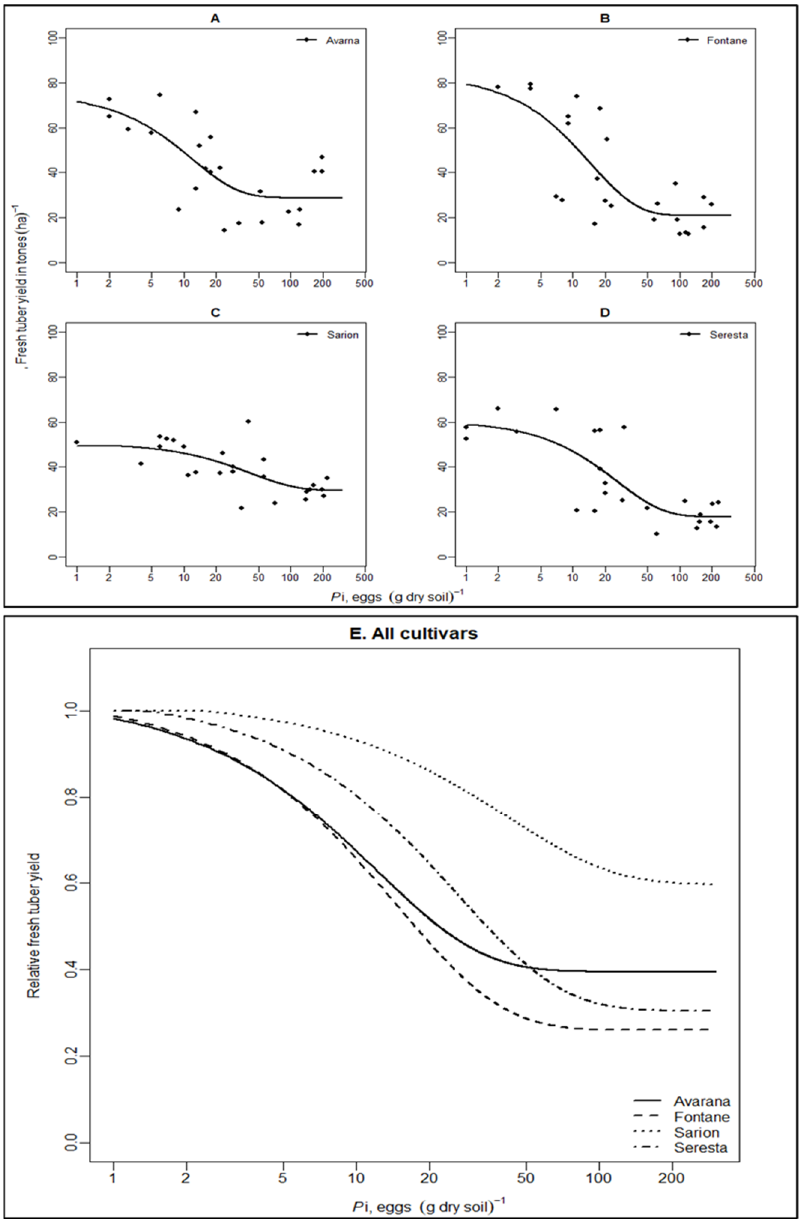
Figure 2. Relationship between P i, eggs (g dry soil) − 1 , and absolute fresh tuber yield in tons (ha) − 1 of four potato cultivars according to Equation (1). (( A ) Avarna; ( B ) Fontane; ( C ) Sarion; ( D ) Serresta). ( E ) Relative fresh tuber yield of all the cultivars